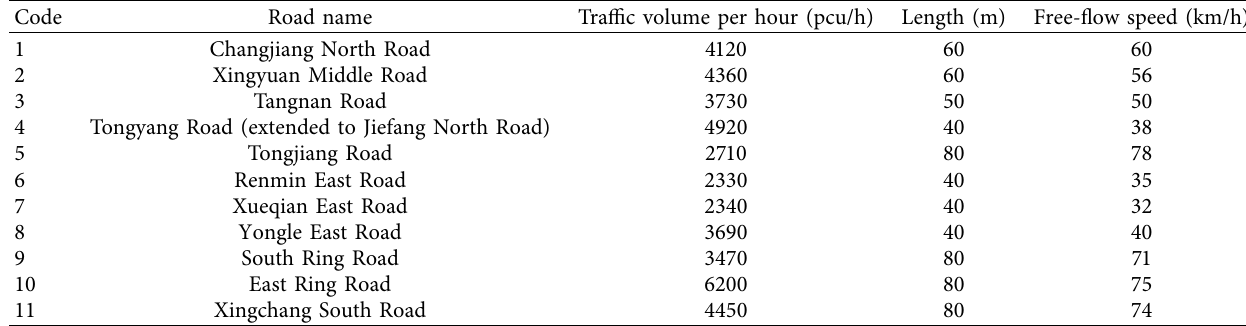
Table 12: The speed of private cars on HOV lanes.